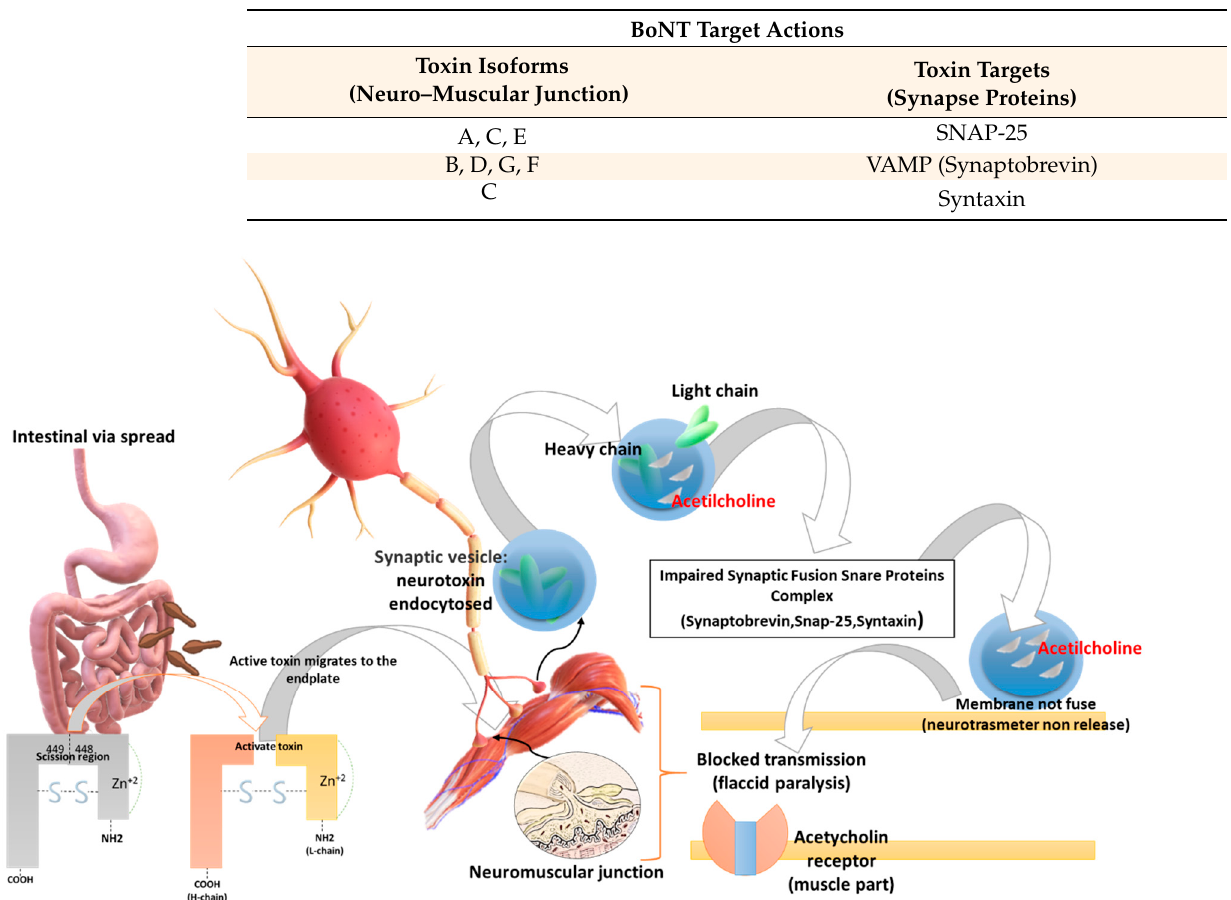
Table 2. The action of BoNTs in the Synaptic Fusion Snare Proteins Complex.